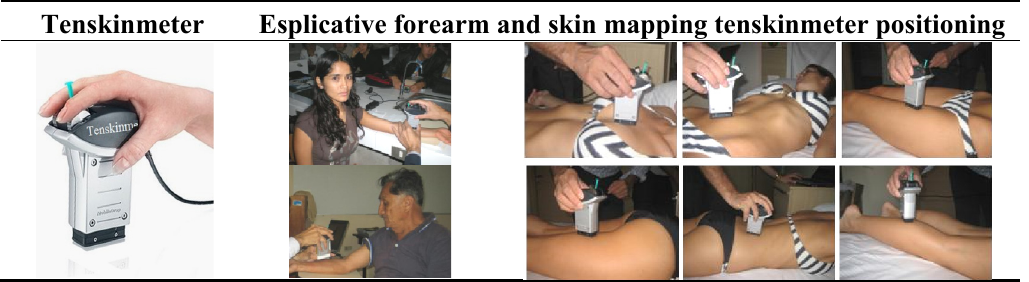
Table 1. The non invasive contact angle measurement by TVS skin test.